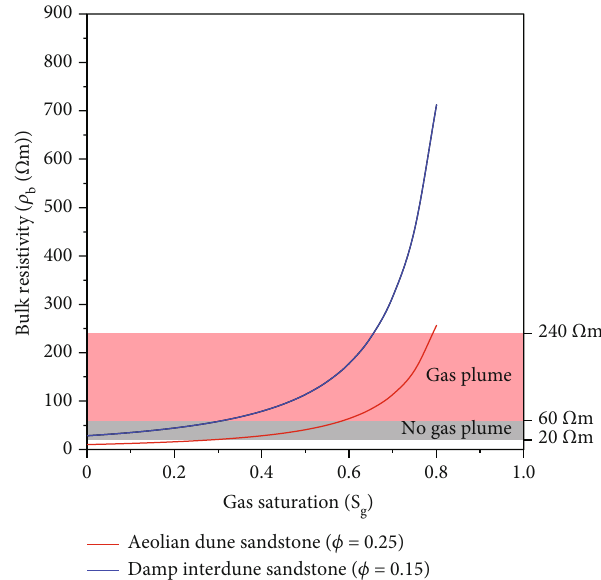
Figure 7: Archie ’ s Law Equation calculated bulk resistivities ( ρ for lithofacies of the Slick Rock Member [26]. FPG saturation ( S was varied from 0 to a maximum value of 0.8. The groundwater conductivity value ( σ ) used in the calculations was 15.6mS/cm. w The shaded areas indicate the tomogram resistivity ranges (5 th to 95 th percentile) for the interpreted boundaries of the free-phase gas plume (Table